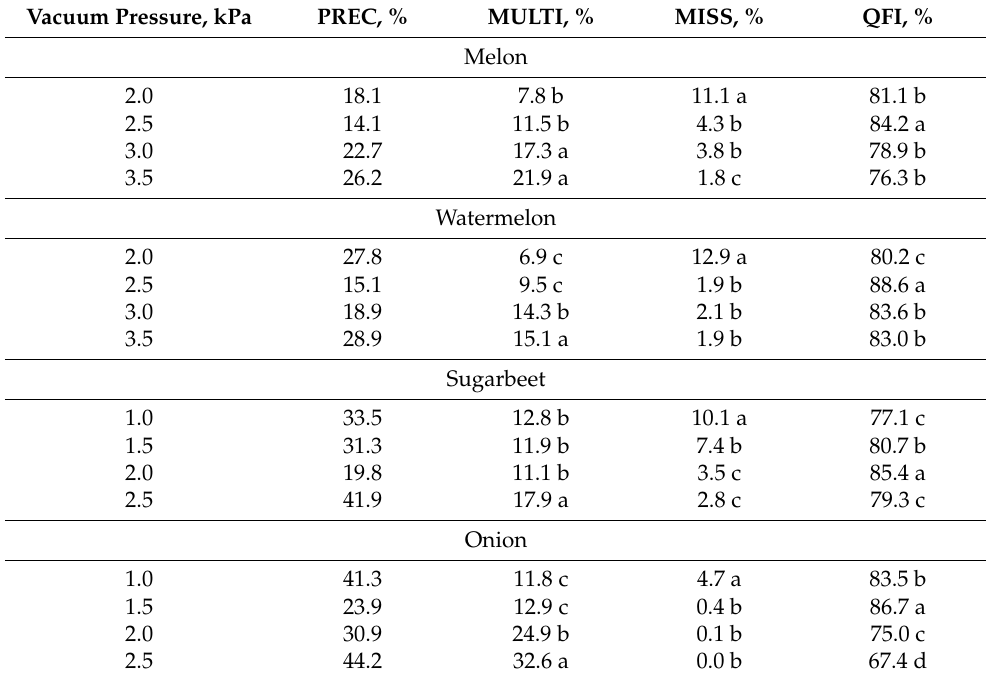
Table 3. Melon, watermelon, sugarbeet and onion seeds metering uniformity of air-suction seed- metering device of precision